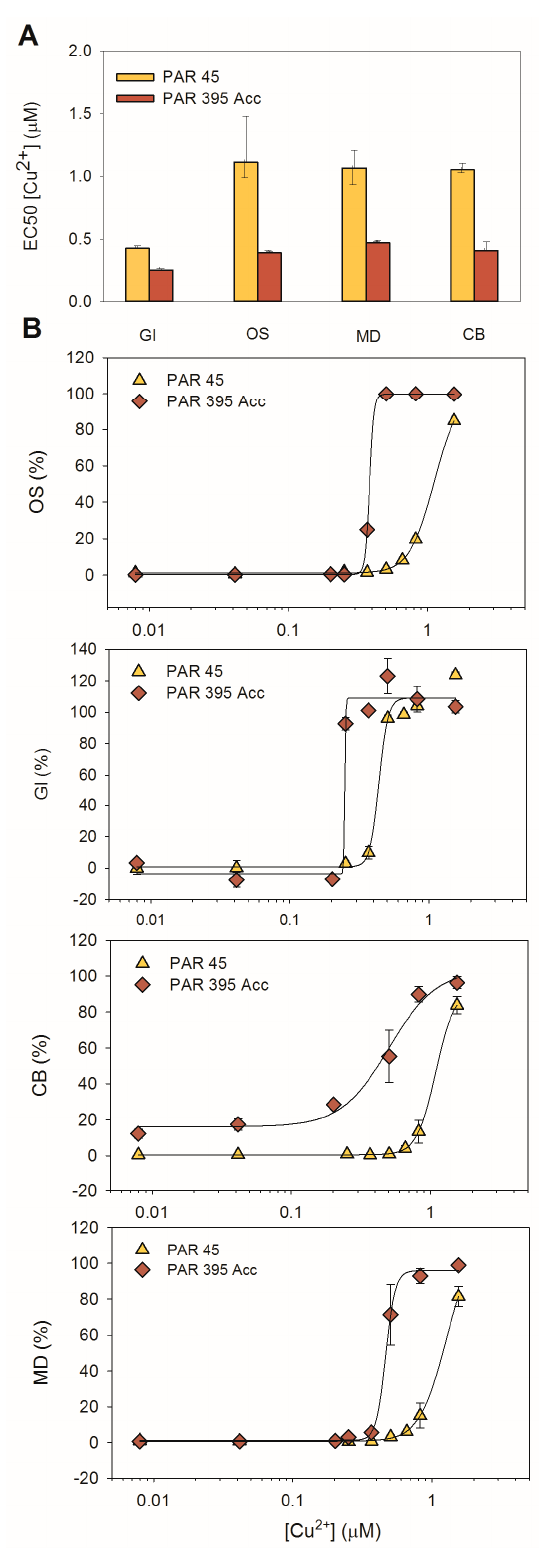
Figure 5. ( A ) Comparison of Cu EC50s for C. reinhardtii acclimated to PAR45 (yellow bars) and to PAR395 (red bars). ( B ) Concentration-response curves for growth inhibition (GI), oxidative stress (OS), membrane damages (MD) and chlorophyll bleaching (CB) of C. reinhardtii exposed to copper. Data points are average values ± standard deviation.